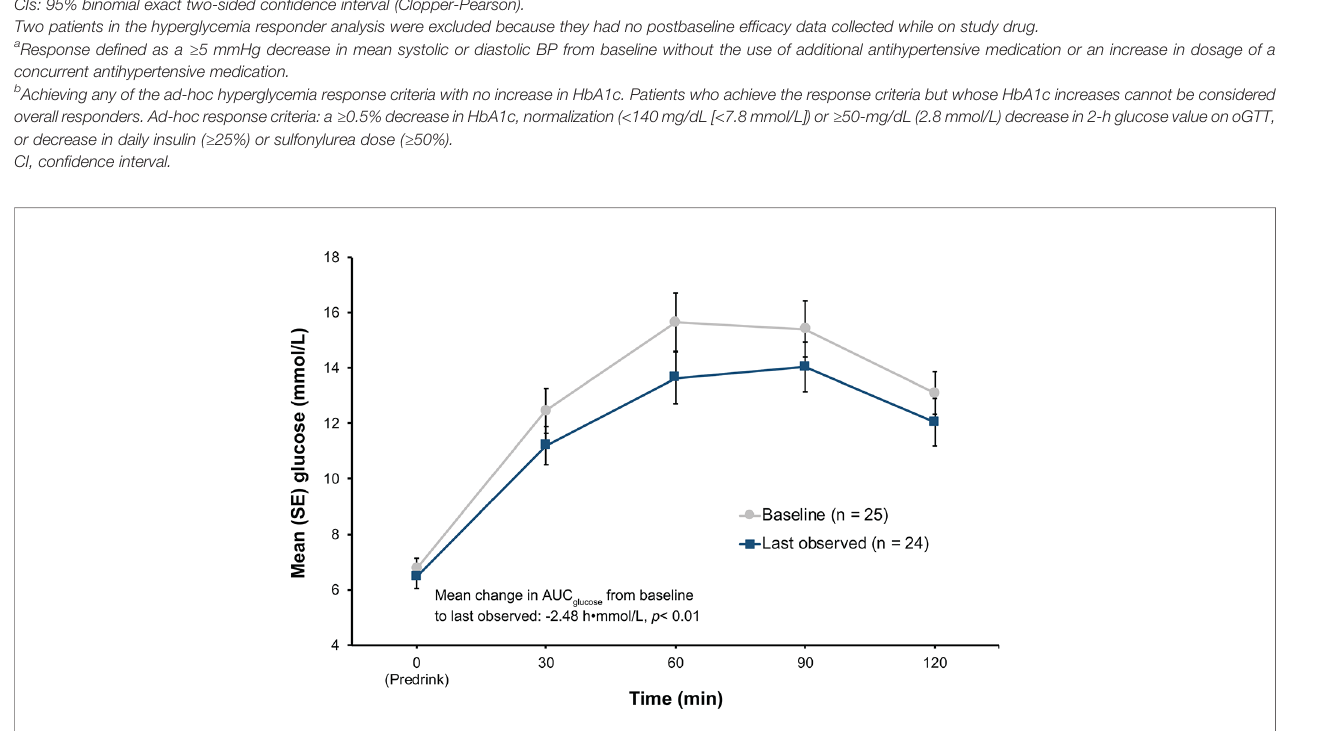
FIGURE 3 | Results of oGTT tests at baseline and at last observation in the hyperglycemia group. p -value from Wilcoxon signed-rank. AUC, area under the curve; oGTT, oral glucose tolerance test; SE, standard